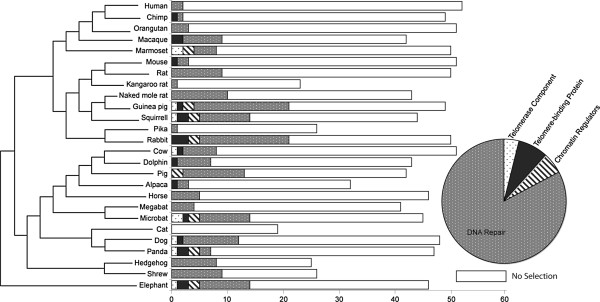
Overview of levels of lineage-specific positive selection on telomere associated genes in each lineage of mammal. Each of the 52 telomere associated genes are categorized into 4 major functional groups (colour coded as per pie chart inset). On the left is the placental mammal phylogeny used. The maximum length of each horizontal bar in the histogram depicts the overall number of times that species was represented in the total dataset of 52 gene families. The shaded portions of the bars correspond to the functional categories (as per colour scheme in the pie chart), the size of these shaded regions represents the proportion of genes in that category that are identified as having undergone lineage-specific positive selection.